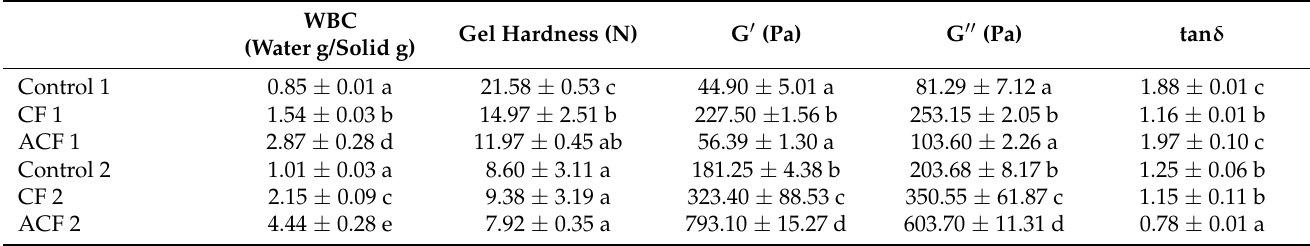
Table 2. Properties of flour/starches/fiber